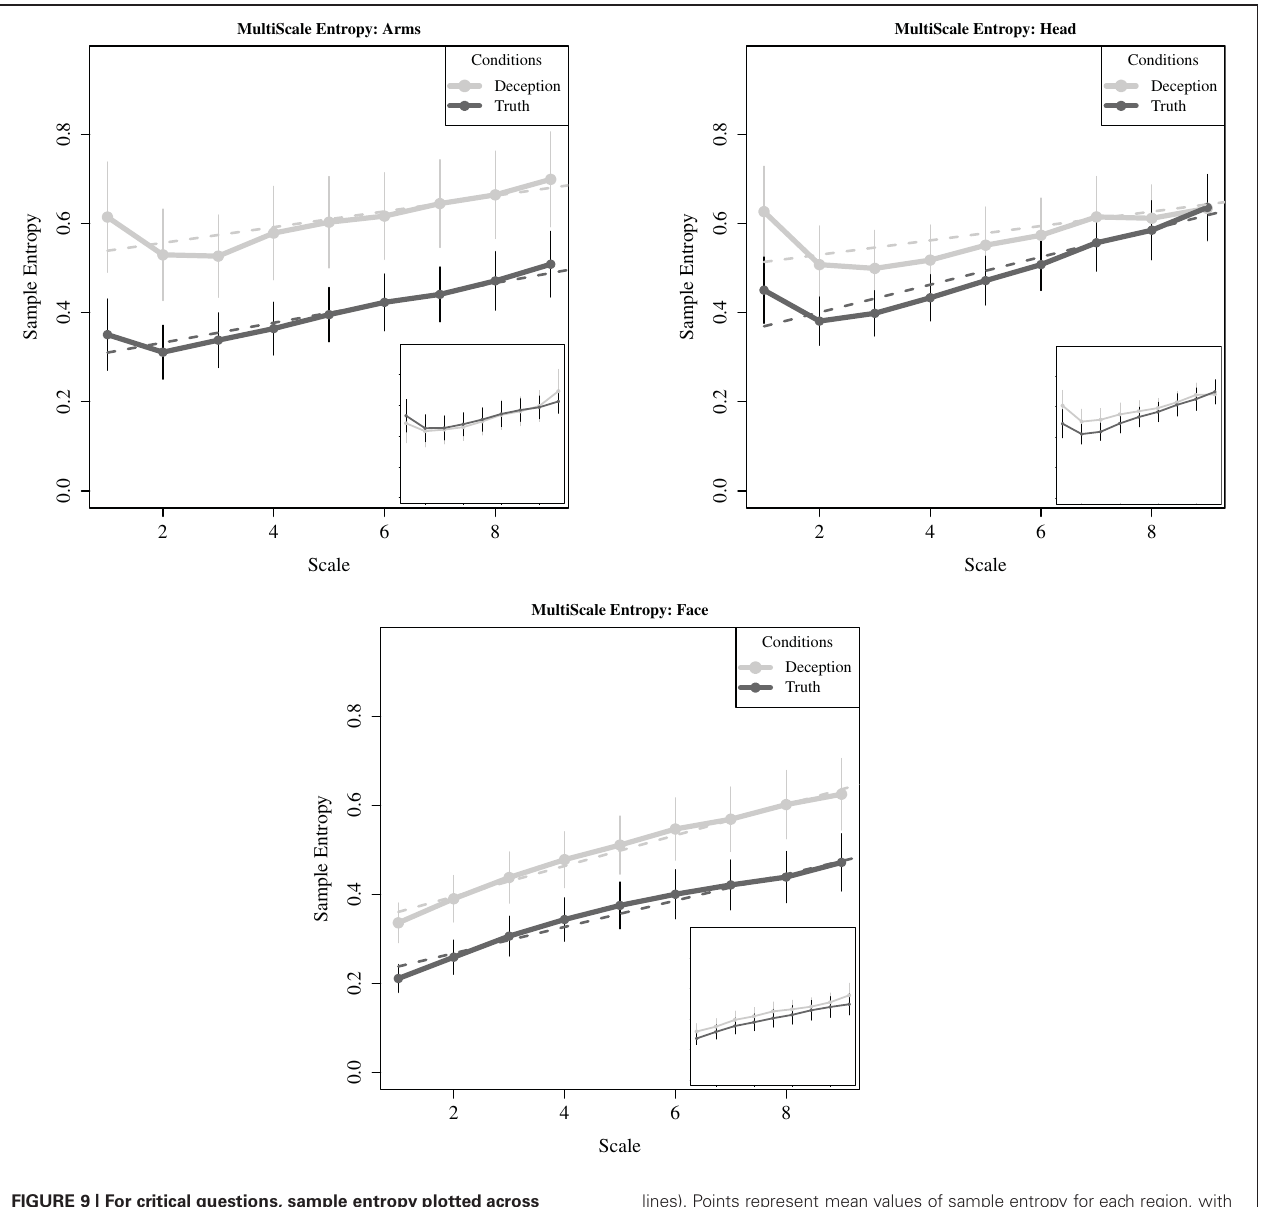
FIGURE 9 | For critical questions, sample entropy plotted across increasing scale lengths, i.e., lower frequencies (solid lines). Curve fitting to individual participant data was conducted using linear fit models for the three motion regions. The average intercept and slope shown here (dashed